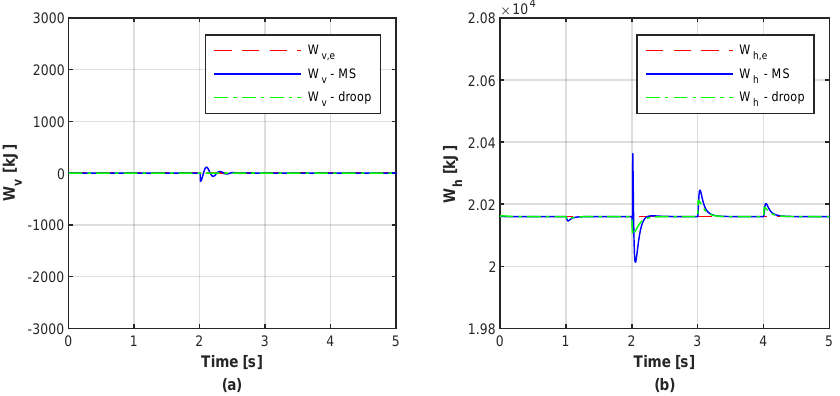
Figure 10. Energy dynamics response from terminal 2: ( a ) energy difference W v ; ( b ) total energy W h